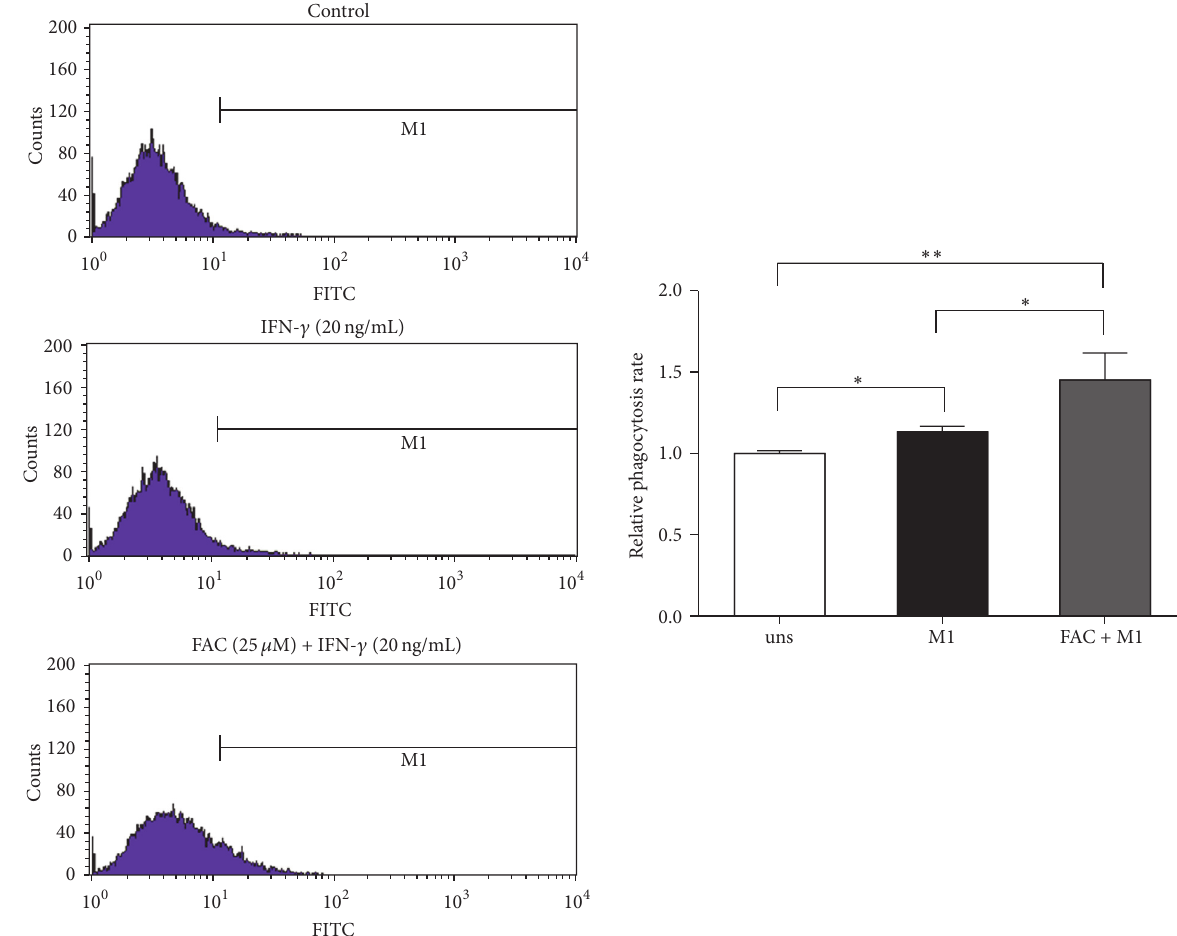
Figure 6: Effect of iron on M1 macrophages phagocytosis activity. RAW264.7 macrophages were polarized to an M1 phenotype in the absence (uns) or presence of 25 𝜇 g/mL of FAC, washed, and incubated with FITC-dextran at 37 ∘ C for 1h; the intracellular FITC-dextran was measured by FACS. Data are mean ± SD for three independent experiments. (uns: unstimulated macrophages; ∗ 𝑝 < 0.05 , ∗∗ 𝑝 < 0.01